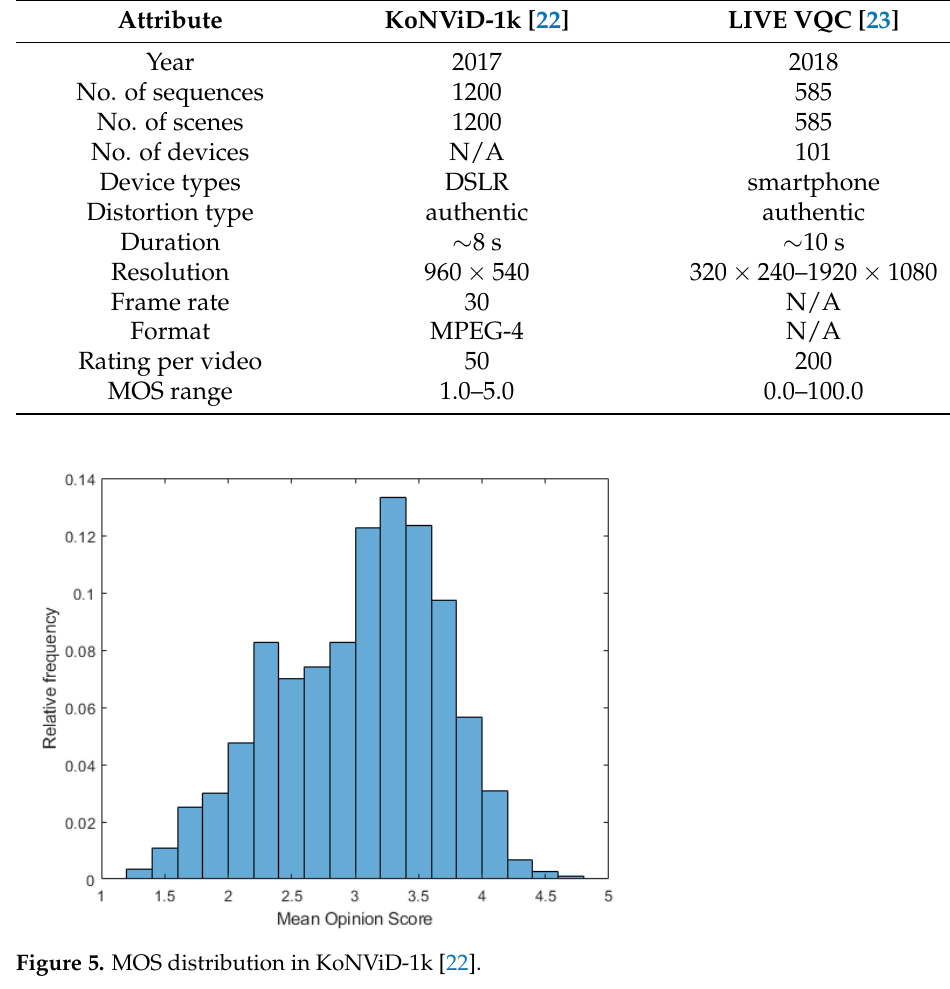
Table 9. Overview of the KoNViD-1k [22] and LIVE VQC [23] publicly available VQA databases.